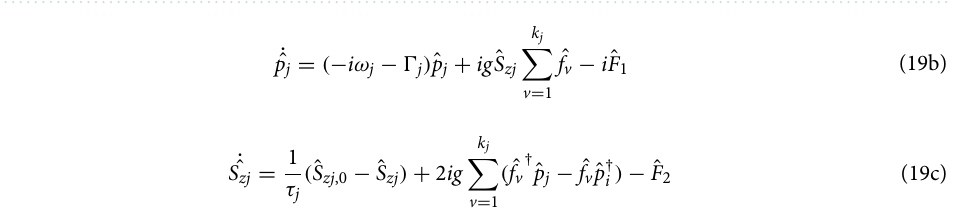
g e and are (emotionally) ground (neutral) and | � | �